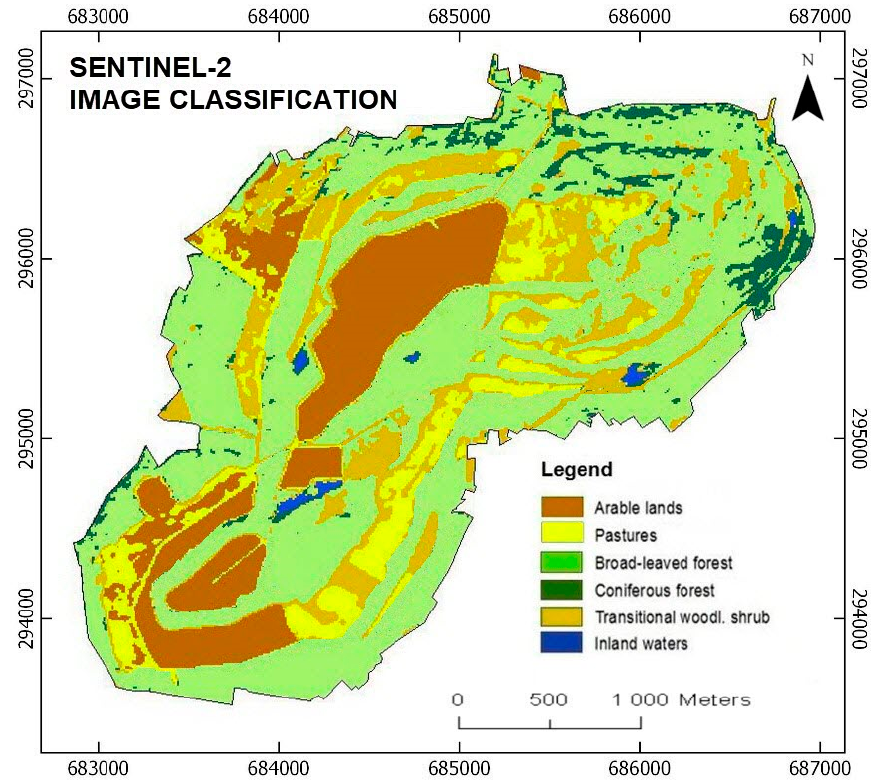
Figure 3. Mach ó w land use and land cover (LULC) classes—results of Sentinel-2 image classification. Figure 3. Machów land use and land cover (LULC) classes − results of Sentinel-2 image Table 1. Accuracy assessment for the Mach ó w area—confusion classification. Table 1. Accuracy assessment for the Machów area − confusion matrix.